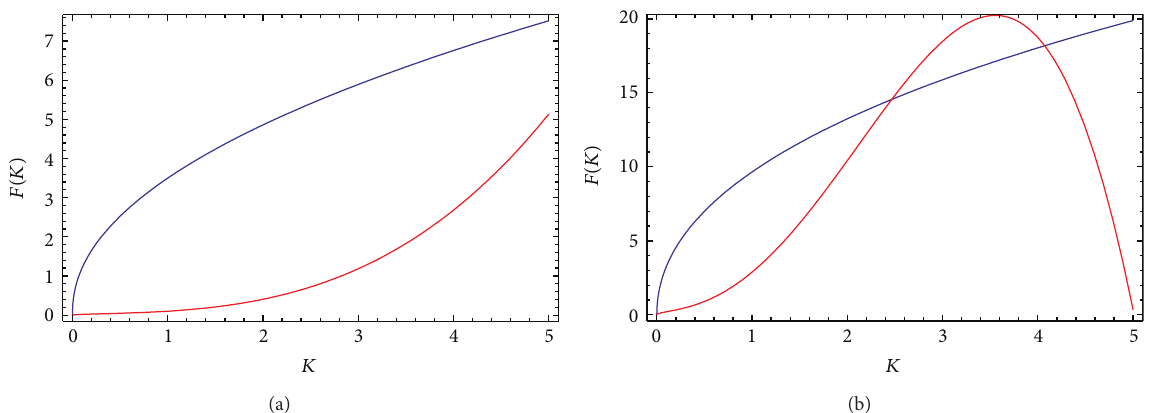
Figure 2: ((a) and (b)) The variations of 𝐹(𝐾) against 𝐾 for NADE and ECNADE models. Blue line represents type I model and red line represents type II